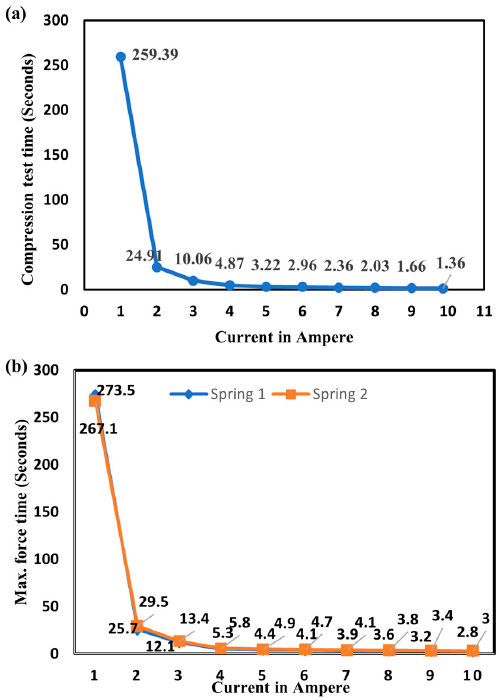
Figure 6. ( a ) Time vs. current graph for compression of spring and ( b ) time vs. current graph for reaching maximum force generated by springs.